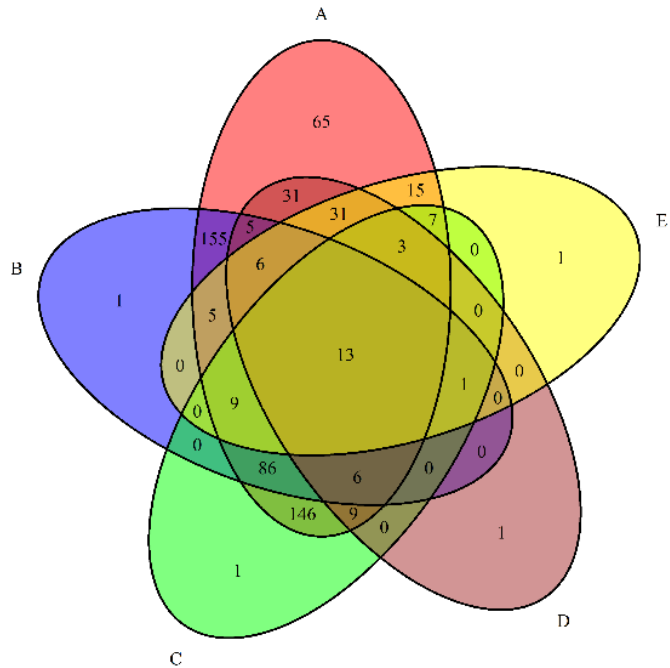
Figure 2. Venn diagram denoting the number of unique and shared species in the different libraries at 3% distance level. A : JBT60 sample, B : JBT70 sample, C : JBT1 sample, D : JBT2 sample, E : SYT sample. The abbreviation of samples is shown in Table